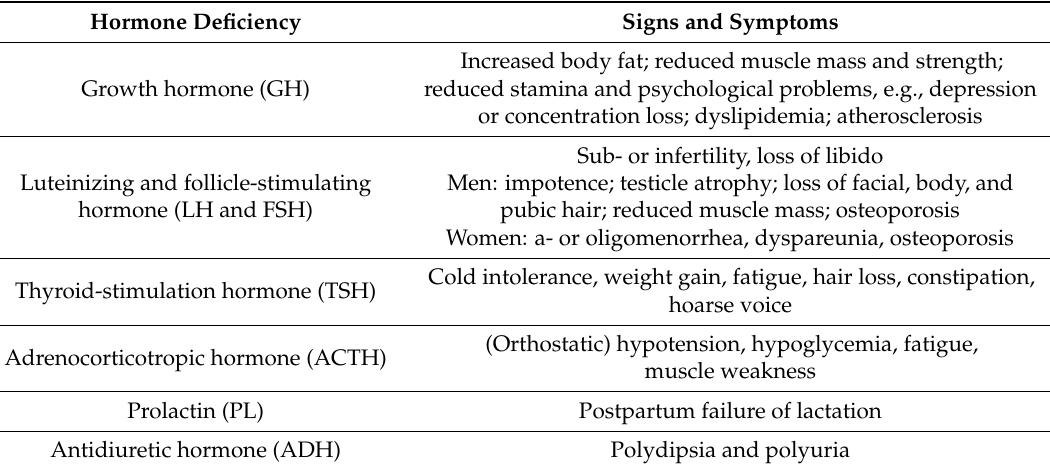
Table 1. Clinical features of hypopituitarism